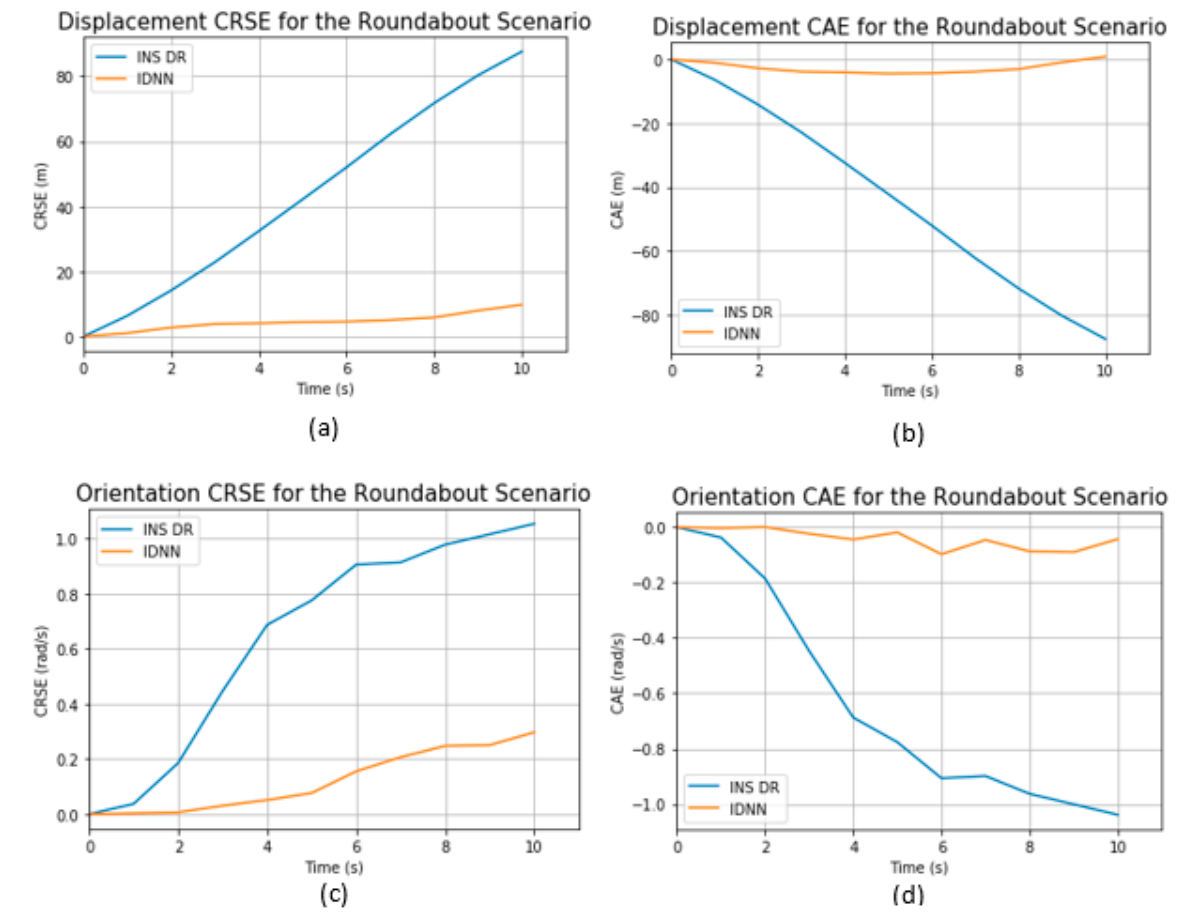
Figure 9. Showing the evolution of the estimation error over time in the roundabout scenario based on the ( a ) Displacement CRSE, ( b ) Displacement CAE, ( c ) Orientation rate CRSE and ( d ) Orientation rate CAE. Table 9. Showing the performance of the IDNN and INS DR on the roundabout scenario.